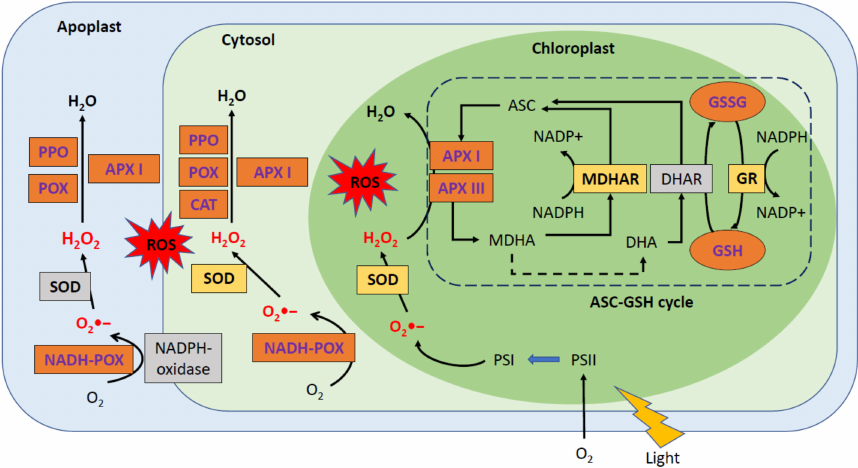
Figure 1. The antioxidant system in peach (GF-305) leaves: main modifications induced by PPV infection. In rectangular form, the enzymatic system, and in oval form, the nonenzymatic system. The orange color indicates an increase of the antioxidant activity, and a yellow color indicates a decrease in the antioxidant activity. The grey color indicates no changes in the enzyme activity. ROS accumulation is shown in red. PPO: Polyphenol oxidase; APX I: class I Ascorbate peroxidase;